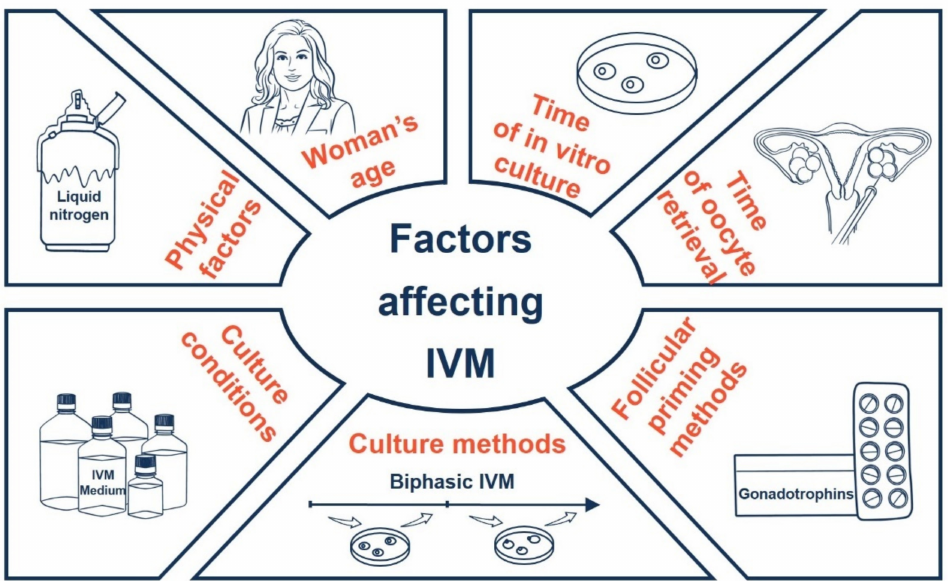
Figure 2. Factors influencing the IVM of human